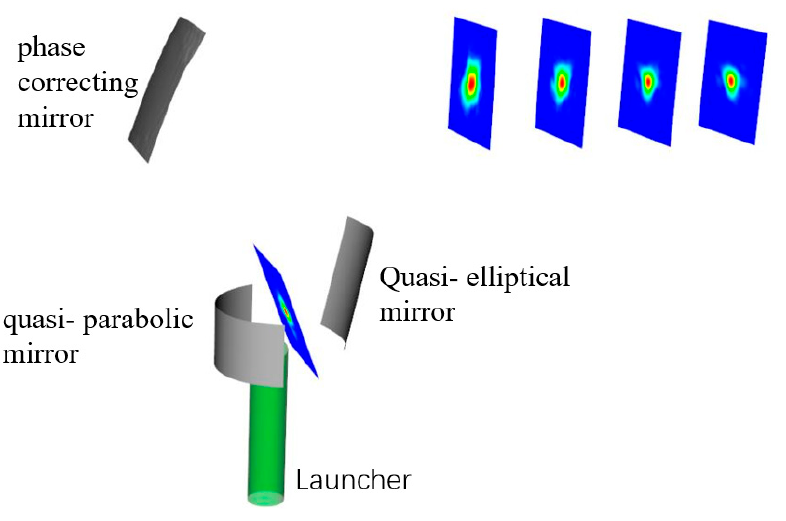
Figure 11. Arrangement of the quasi-optical mode converter for the 170 GHz, TE 25,10 mode gyrotron. Combined with the BUAA (Beijing University of Aeronautics and Astronautics), we established the TE 25,10 mode generator and measured the output aperture field distribution, as shown in Figure 12. The experimental results showed that the amplitude and phase were close to the simulated result, but the content of the TE 25,10 mode component was not ideal. The efficiency of the coaxial cavity was relatively low, while the power reflected by the quasi-parabolic mirror was about − 25 dBm, and the output power of mode generator was in the range of − 140 dBm to − 65 dBm. We are currently optimizing the mode generator and test methods to improve the precision of the mode converter measurement